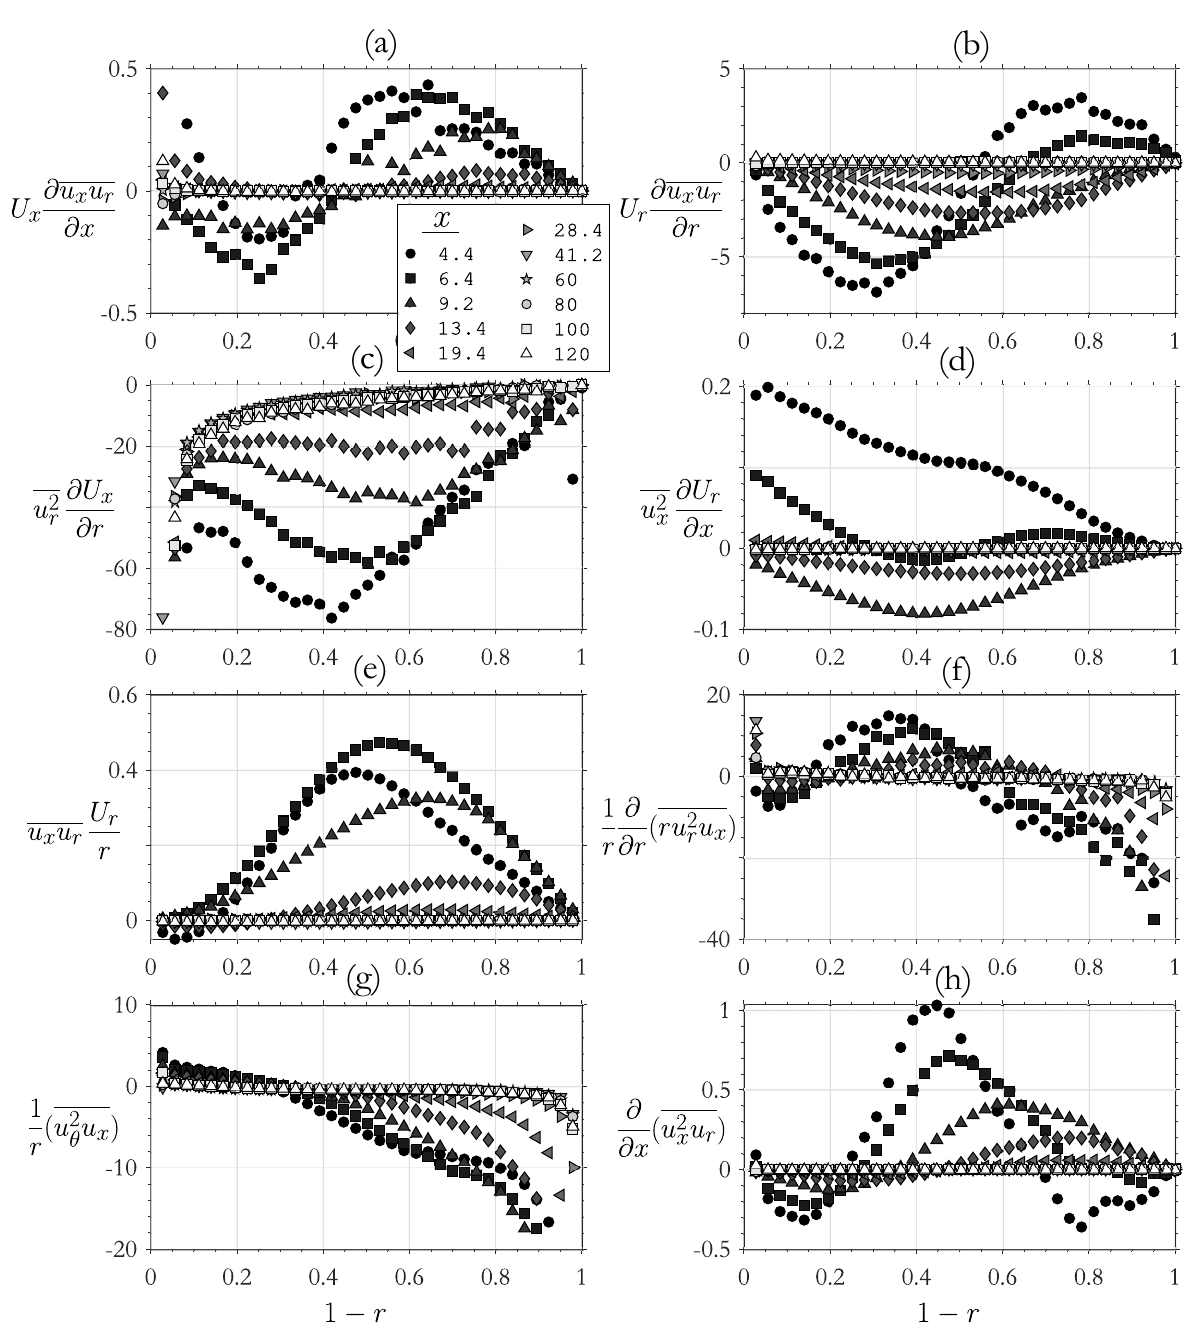
Figure 3. Downstream development of the terms in the transport equation for u x u r of turbulent pipe flow responding to a change in surface roughness. ( a , b ) mean advection; ( c – e ) production; ( f – h ) turbulent convection. (Reproduced with permission from [37], published by Cambridge University Press